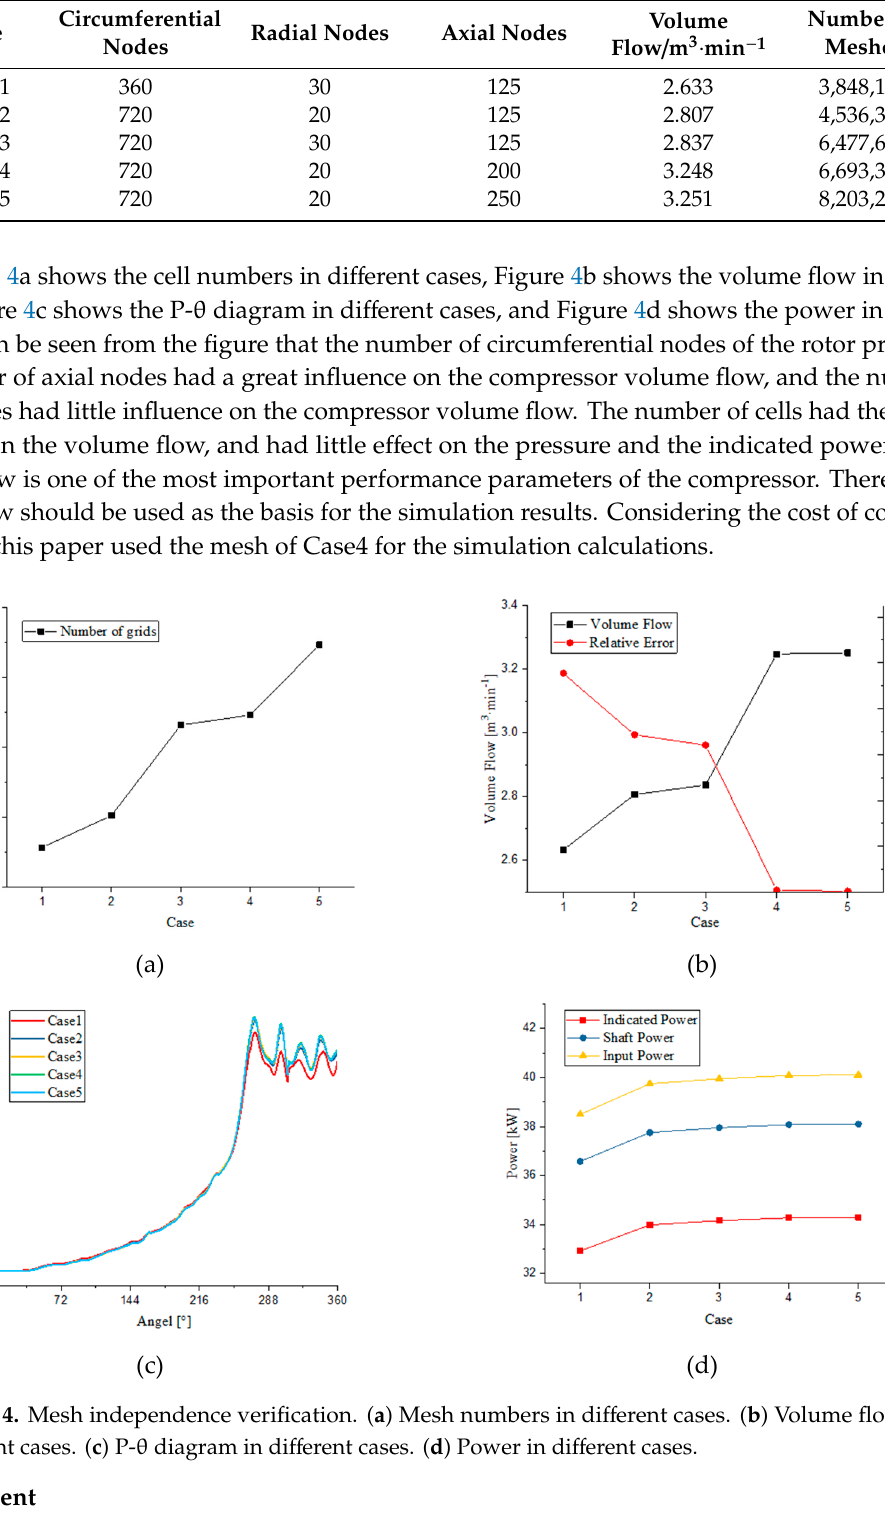
Table 2. Grid independence verification.